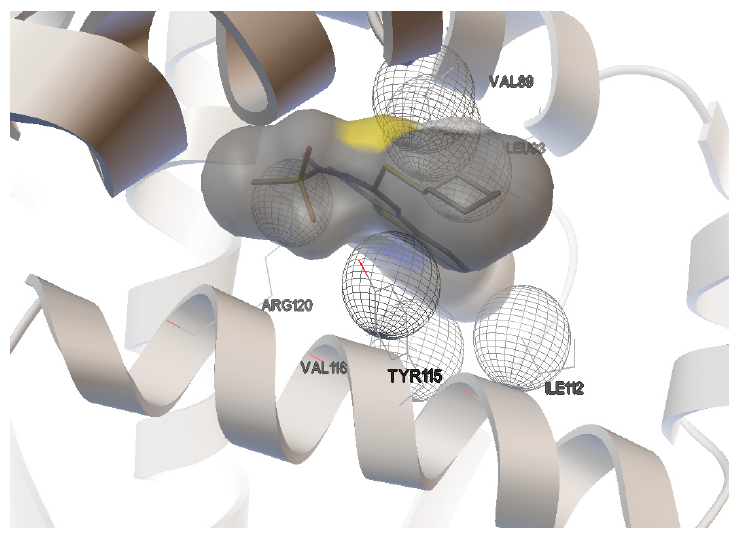
Figure 2. Binding of 1 into the active site of COX–2.